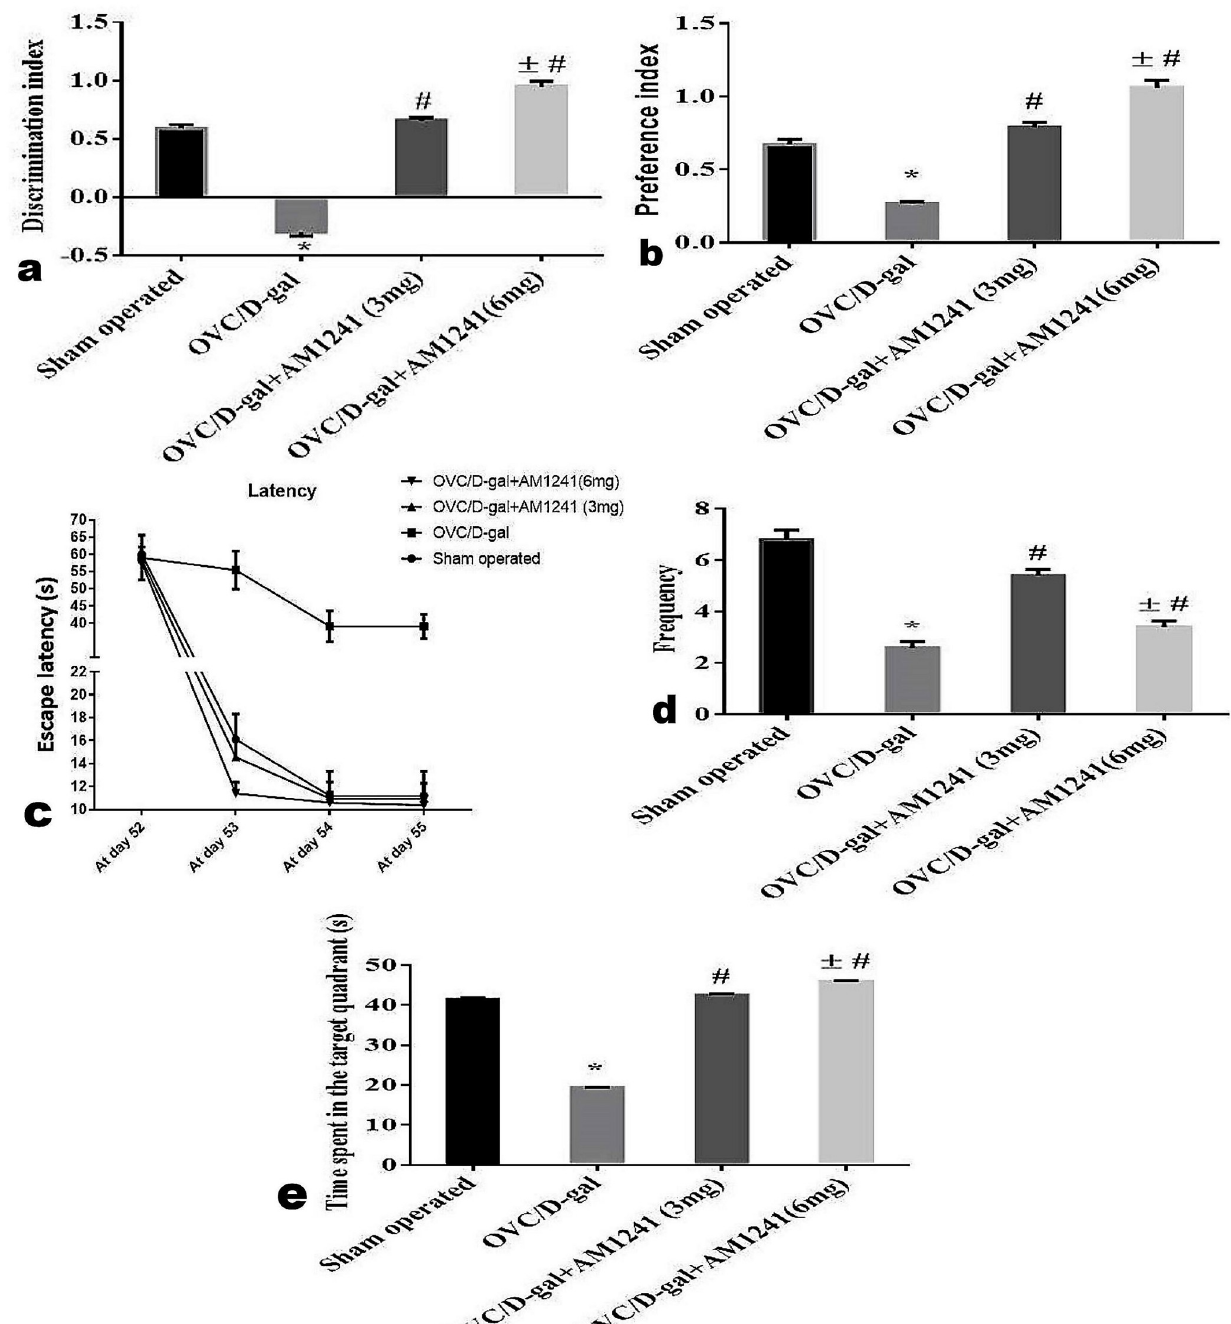
Fig 2. Effect of AM1241 on cognitive functions of OVC/D-gal rats in (a and b) Novel object recognition and (c-e) Morris water maze tests. Data were analyzed by using one way ANOVA followed by Tukey’s post hoc test. Values expressed as mean ± SE. � , #, and ± statistically significant different at P < 0.05, where; � statistically significant different comparing with control group, # statistically significant different comparing with OVC/D-gal group, ± statistically significant different comparing with AM1241 (3mg/Kg).